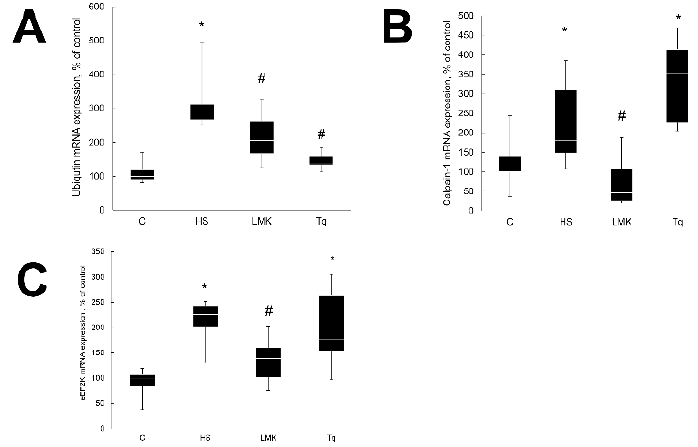
Figure 2. Evaluation of the ubiquitin ( A ), calpain-1 ( B ) and eEF2k ( C ) mRNA expression in soleus muscles of nontreated control rats (C), rats after 3 days of unloading (HS), 3 days HS with LMK-265 inhibitor (HSLMK) or HS with Tq inhibitor (HSTq). Values are normalized to the levels of GAPDH mRNA expression in each sample. n = 8. * indicates a significant difference from the control, p < 0.05; # indicates a significant difference from the HS, p < 0.05.